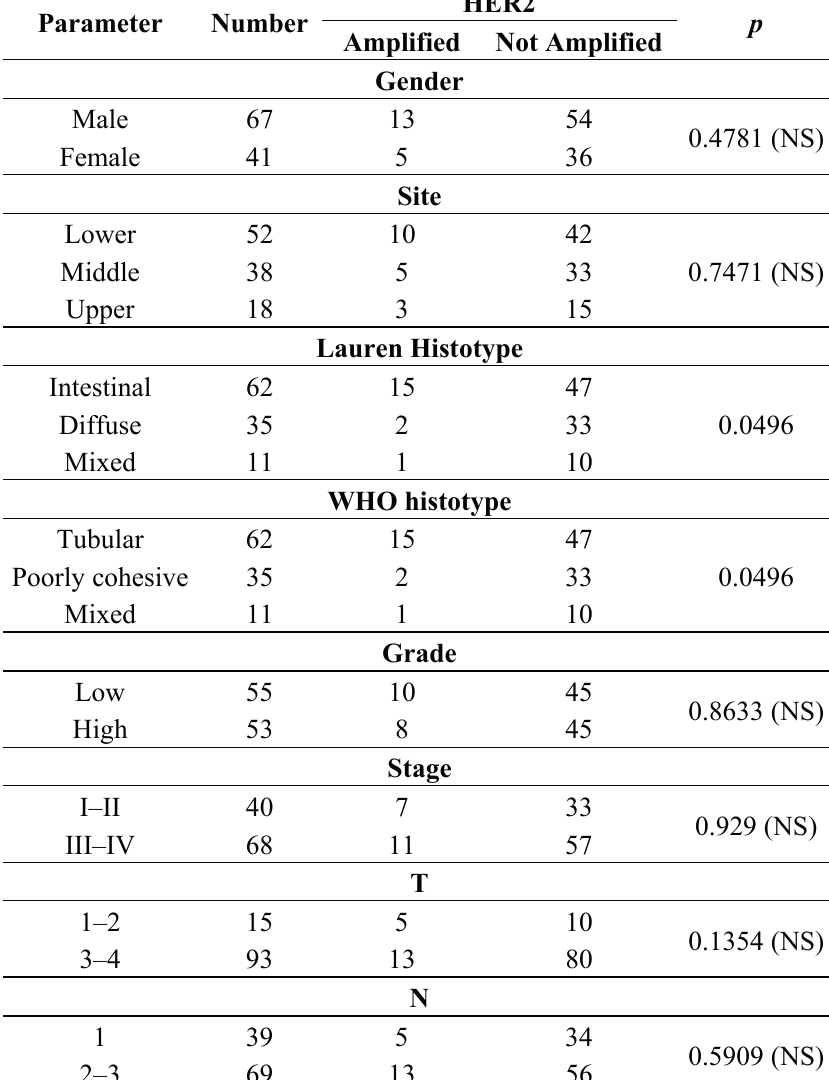
Table 1. Clinico-pathological parameters in relation to HER2 status in 108 primary gastric carcinoma (GC)